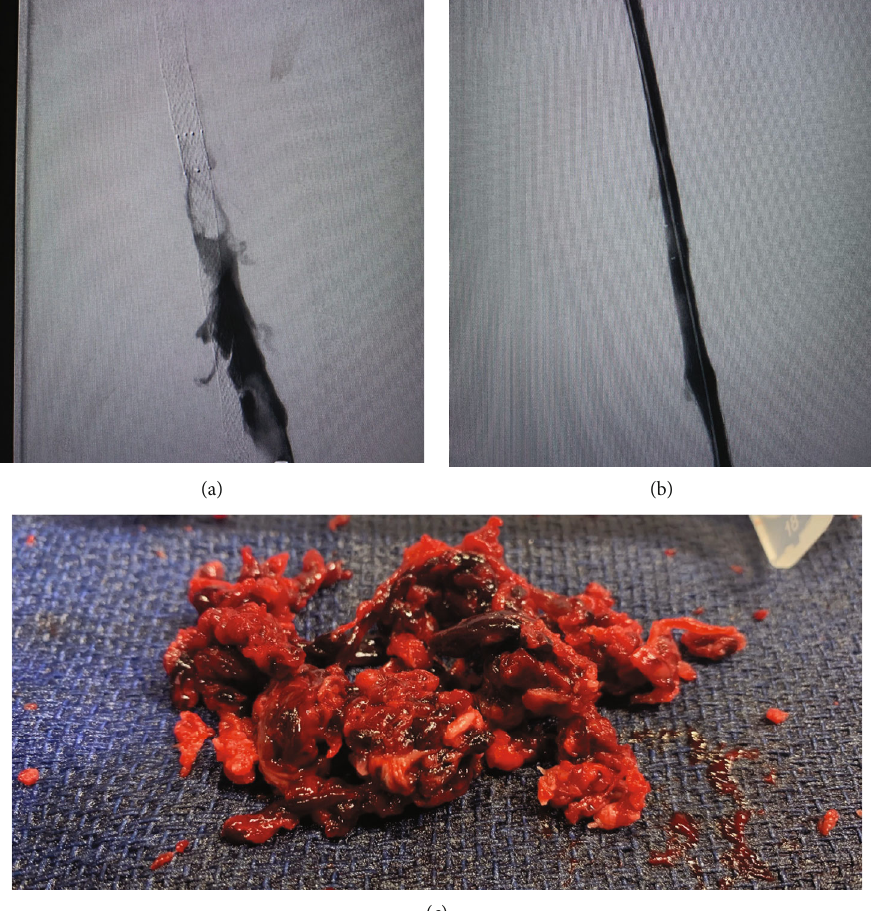
Figure 3: Venography of the lower extremity: (a) absence of blood fl ow due to thrombus; (b) restoration of blood fl ow after thrombectomy; (c) large amount of thrombus extracted using the ClotTriever